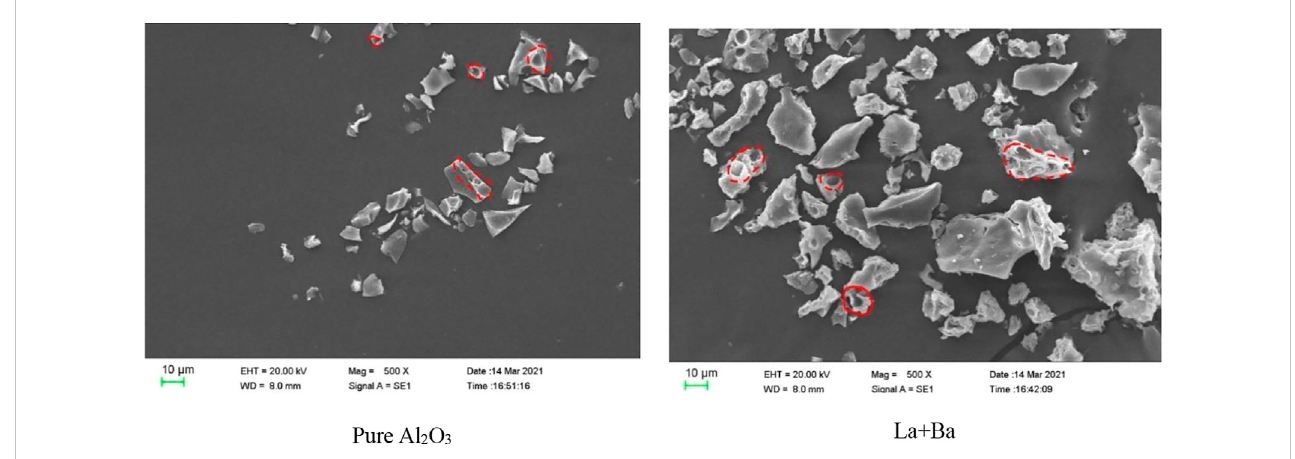
FIGURE 8 SEM image after aging at 1,100 ° C.